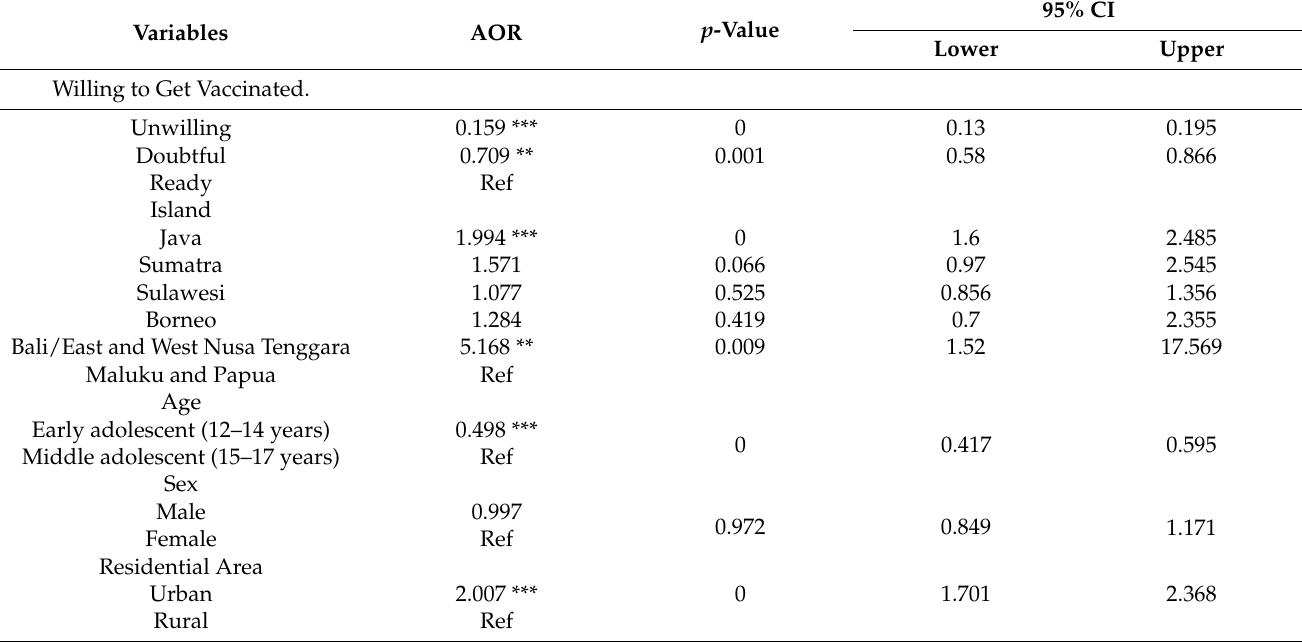
Table 3. Factors associated with adolescents’ adherence to COVID-19 vaccination using binary logistic regression ( n =